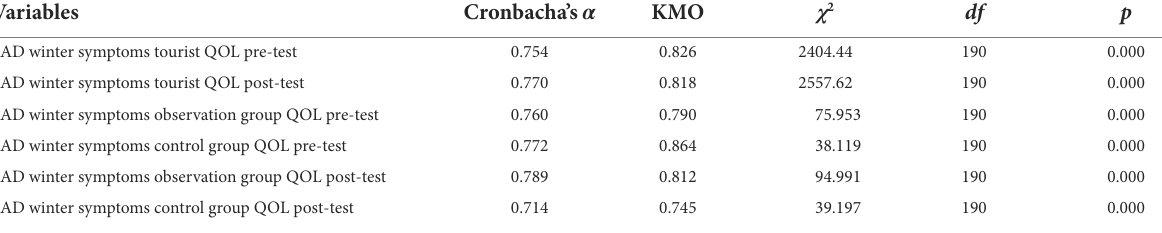
TABLE 3 Results of reliability and validity analysis of the SAD Winter Symptom tourists